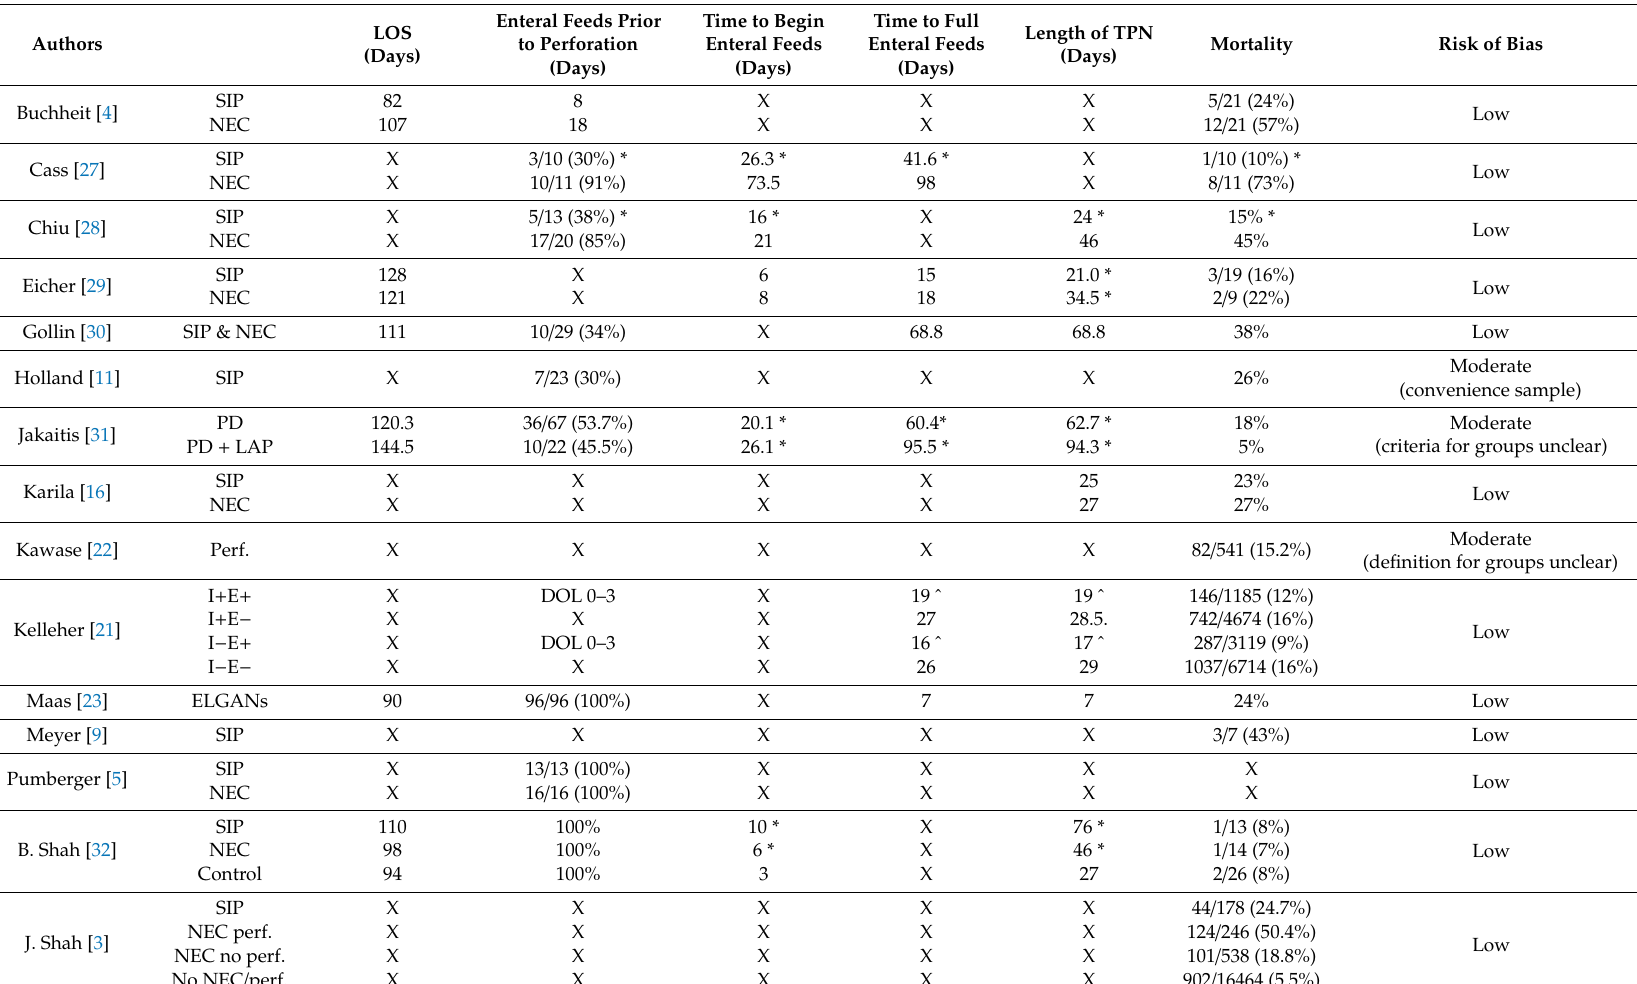
Table 4. Outcomes of studies that document feeding regimens prior to SIP diagnosis and those that document post-operative nutrition in SIP